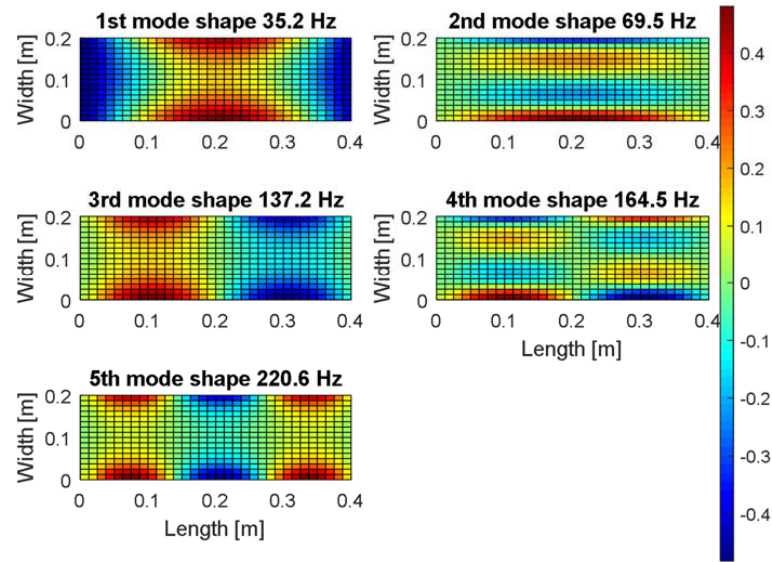
Figure 4. The mechanical strains fields in Y direction of the smart SFSF plate with integrated piezo-elements for the first five mode shapes.